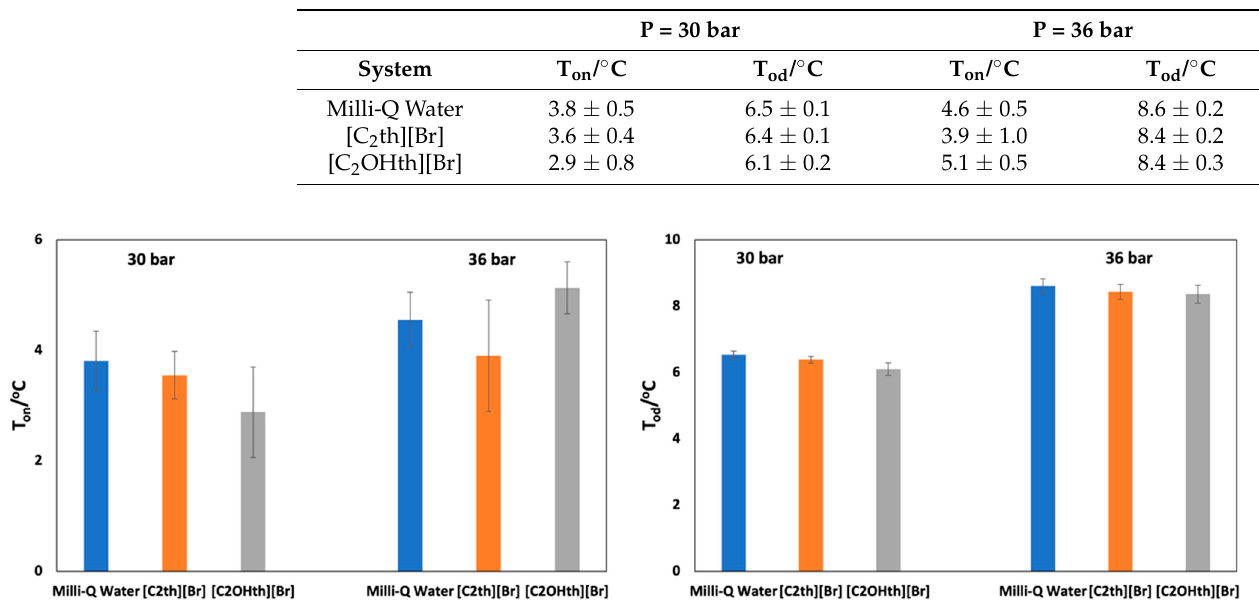
Table 2. Average nucleation (T on ) and dissociation (T od ) onset temperatures for Milli ‐ Q water and 1 wt% aqueous ionic liquids solutions obtained from 12 experiments for each data point along with standard deviations using the constant ramping method.